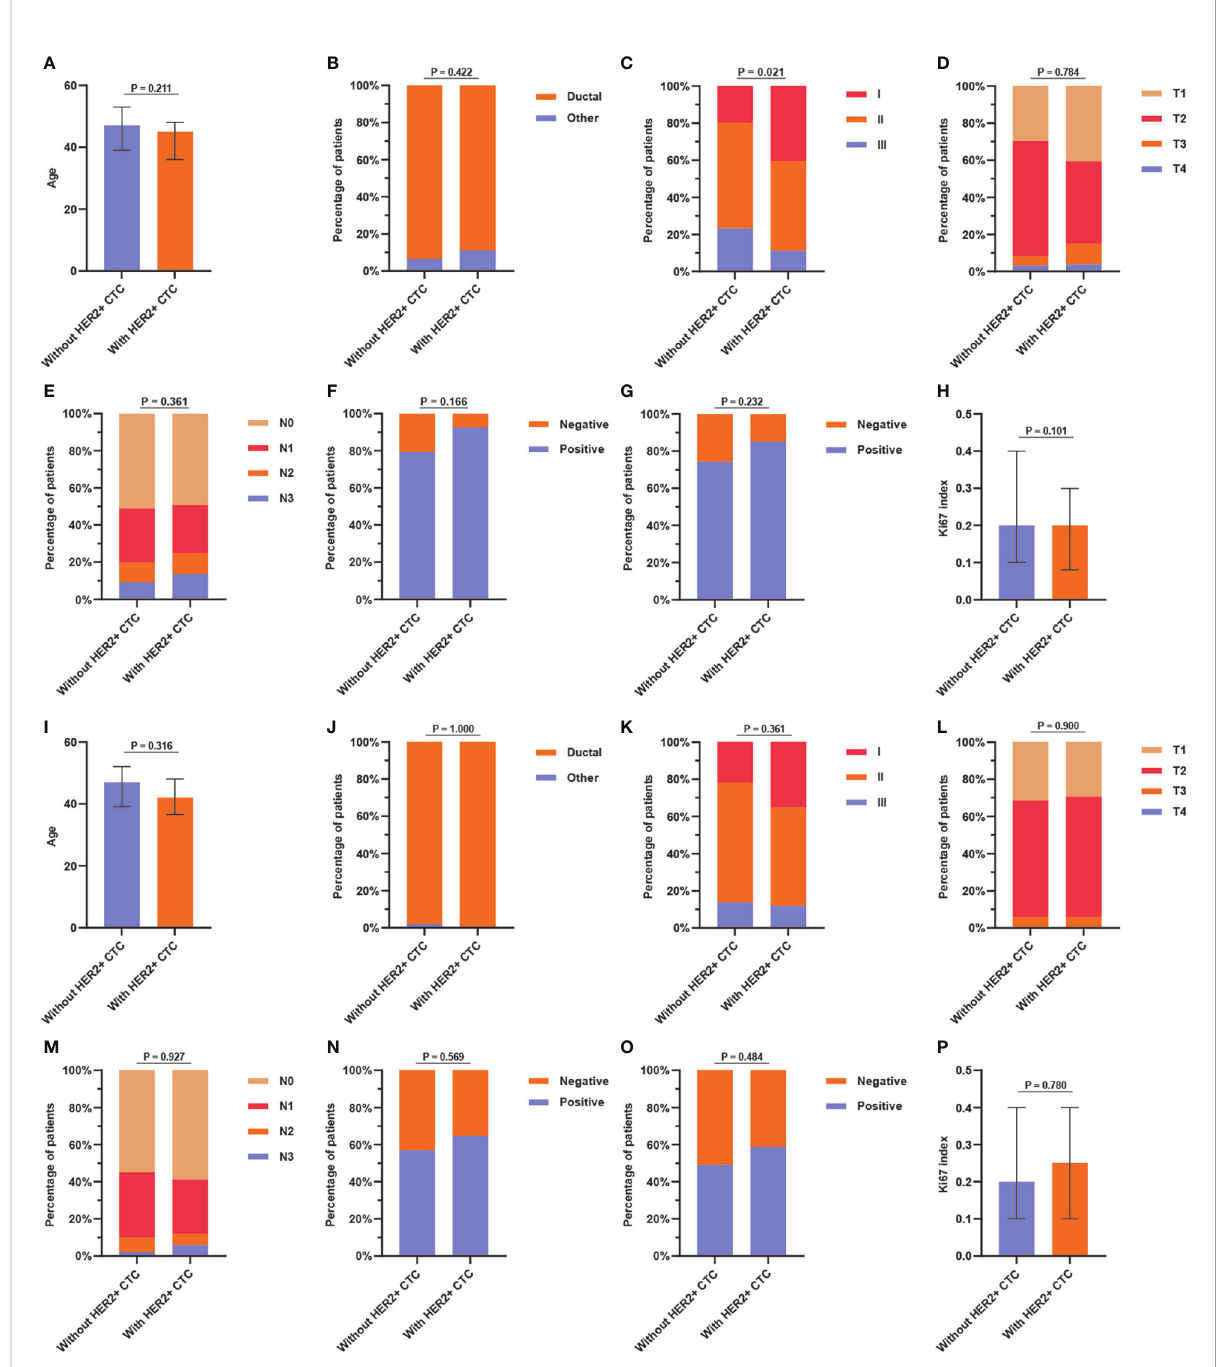
FIGURE 3 Association between (A) age, (B) pathological type, (C) TNM stage, (D) tumor size, (E) nodal status, (F) ER status, (G) PR status, and (H) Ki67 index and HER2+ circulating tumor cells status in tHER2- patients, and the association between (I) age, (J) pathological type, (K) TNM stage, (L) tumor size, (M) nodal status, (N) ER status, (O) PR status, and (P) Ki67 index and HER2+ circulating tumor cells status in tHER2+ patients. Note: age and Ki67 index present in median with the interquartile